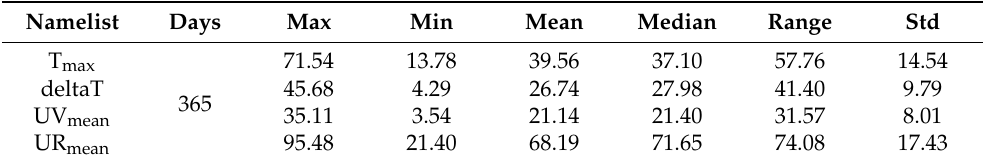
Table 2. Statistical indices calculated for input weather data values, onshore location, 2021.